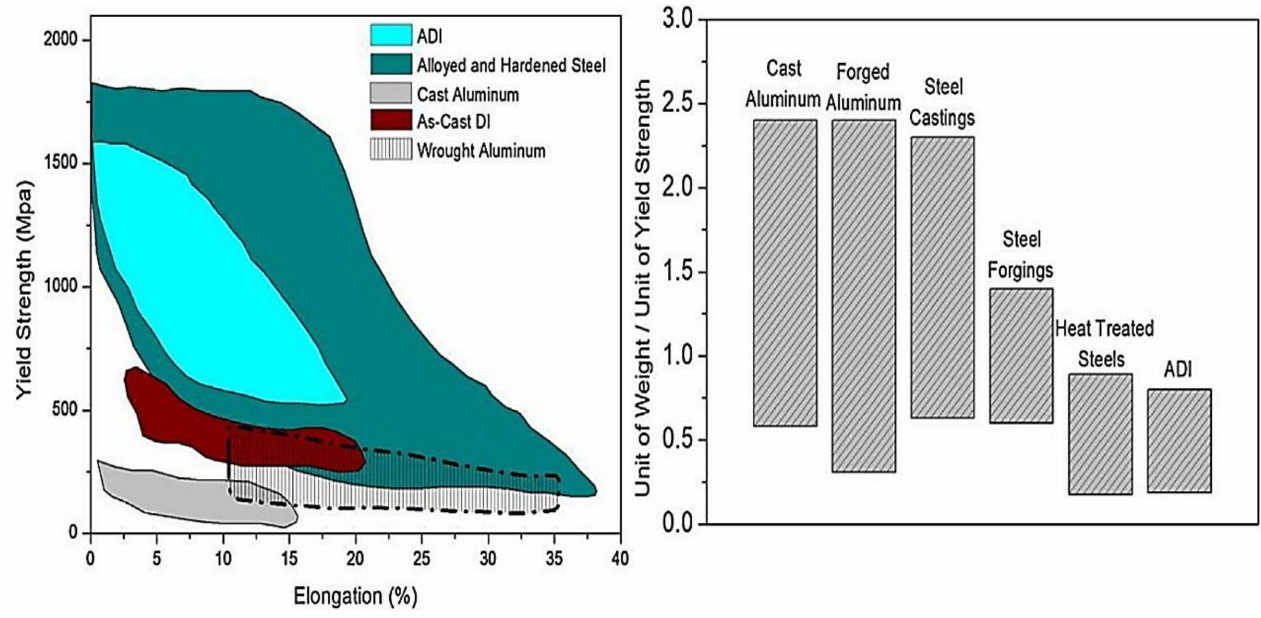
Figure 1. Graphite cast irons compared to similar engineering materials in terms of yield strength, elongation, unit weight, and unit cost